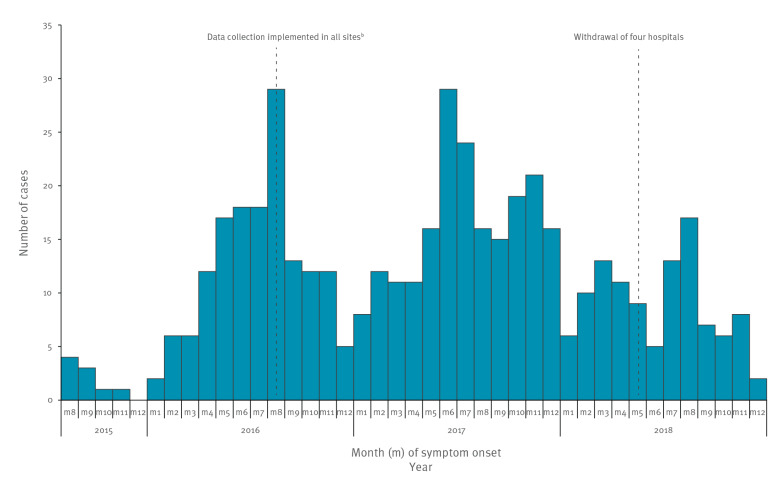
Hospitalised Bordetella pertussis cases aged < 1 year by month of symptom onset, PERTINENT study, Europe, 1 December 2015–31 December 2018 (n = 464 casesa)